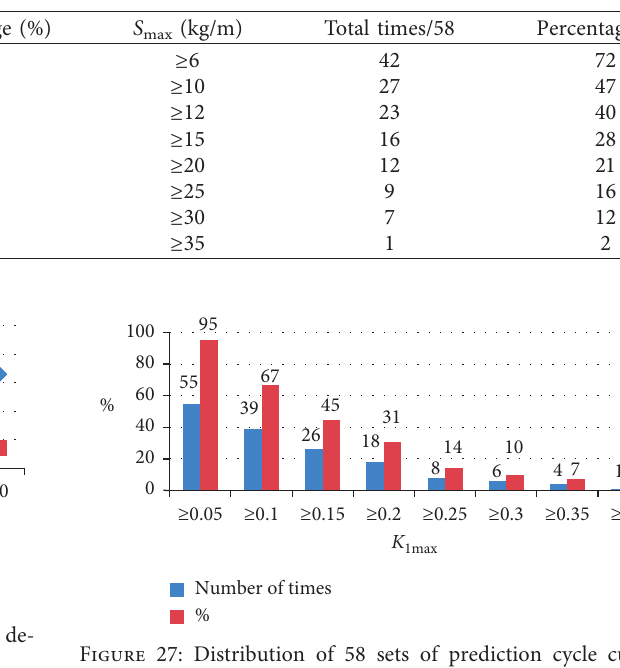
Table 6: Prediction cycle percentage-based statistics of cuttings desorption index.